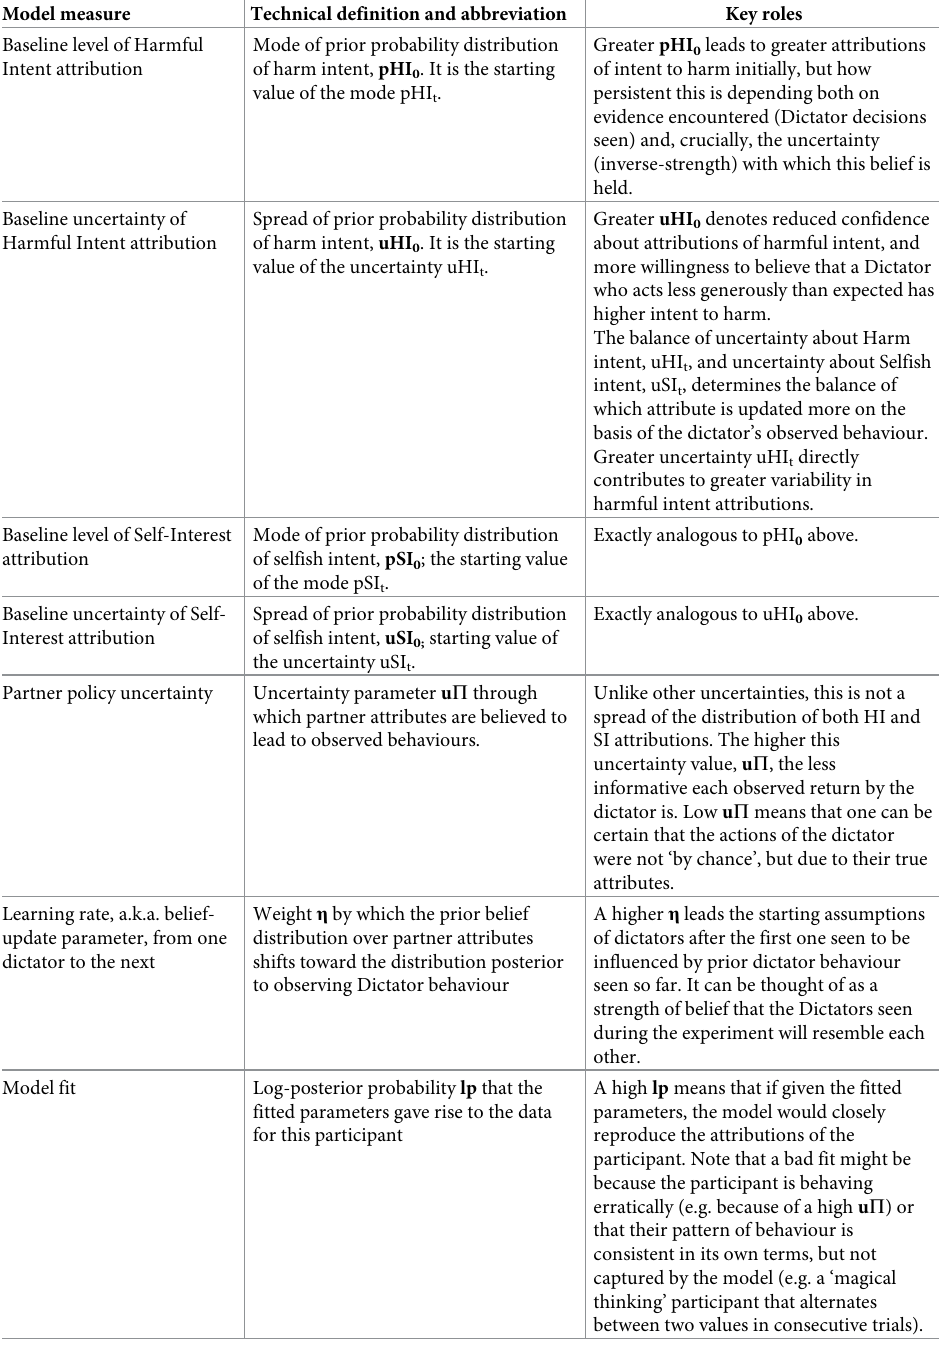
Table 1. Glossary of model terms and model